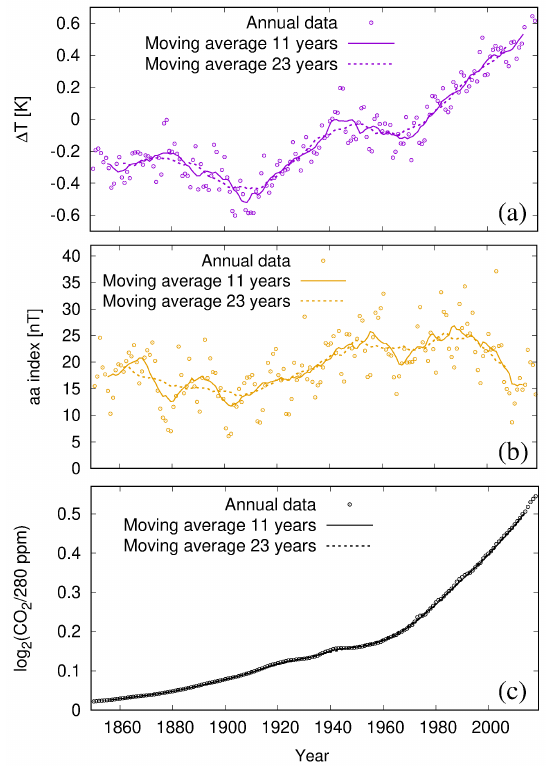
Figure 1. Data of the HadSST sea surface temperature anomaly ∆ T ( a ), the aa index ( b ) and log the ratio of the CO 2 concentration to the reference value of 280 ppm ( c ). The annual data between 1850 and 2018 are complemented by centered moving averages with windows 11 years and 23 years, as also utilized by Mufti and Shah [46]. The sources of the data are described in the